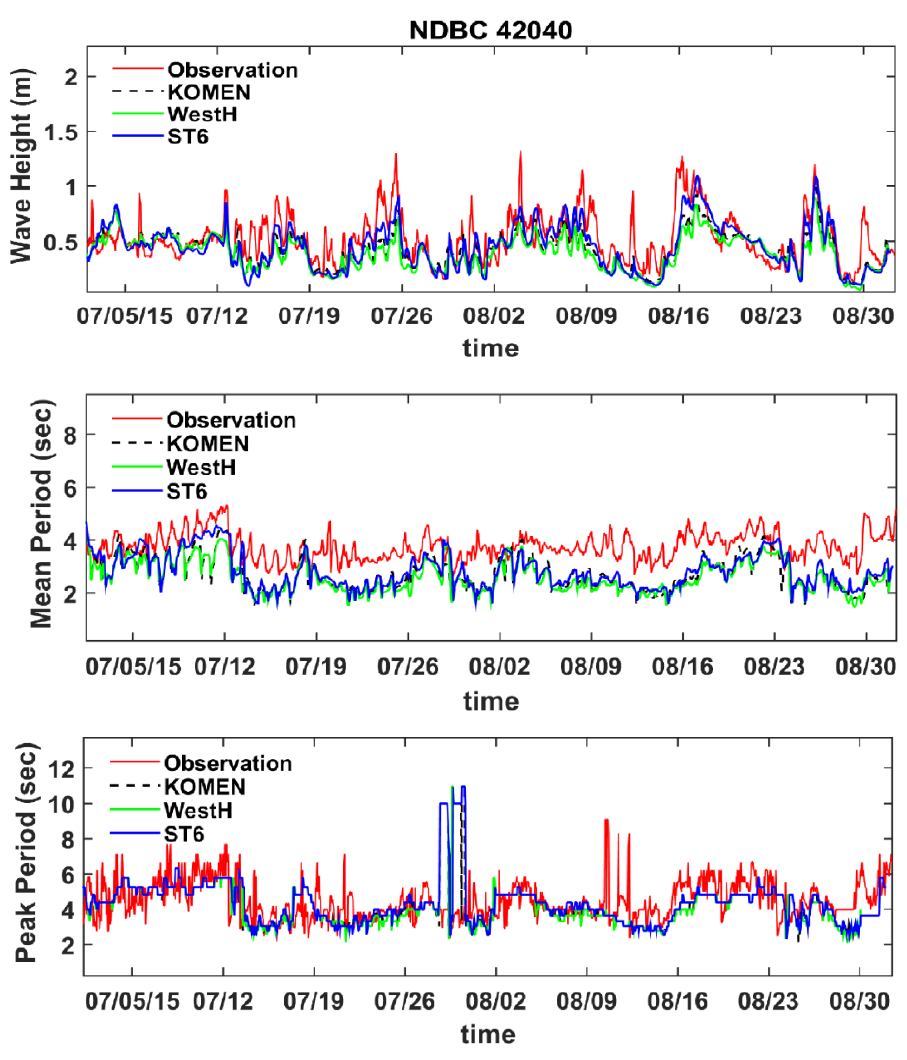
Figure 5. Comparison of simulated wave parameters using different whitecapping formulations with observations at NDBC 42040 between July and August 2015. To quantify the performance of each whitecapping formulation in simulating wave heights at these two stations, four standard metrics, including Pearson correlation coef- ficient (R), bias, root mean square error (RMSE), and scatter index (SI), were employed (Appendix A for detailed formulations). As expected, the metrics show a better perfor- mance of ST6 at both stations (Figure 7). At NDBC 42040, using the ST6 increases the correlation coefficient to 0.732 compared to 0.588 and 0.659 for Westhuysen and Komen, respectively. Bias and RMSE as metrics representing the model general and average error decrease when using ST6. For example, the RMSE value decreases to 0.173 m compared to 0.221 m and 0.190 for Westhuysen and Komen, respectively. A similar pattern is shown at LOPL1. For instance, the bias at this station decreases to 0.074 m, while for Westhuysen and Komen, the bias is 0.128 m and 0.091